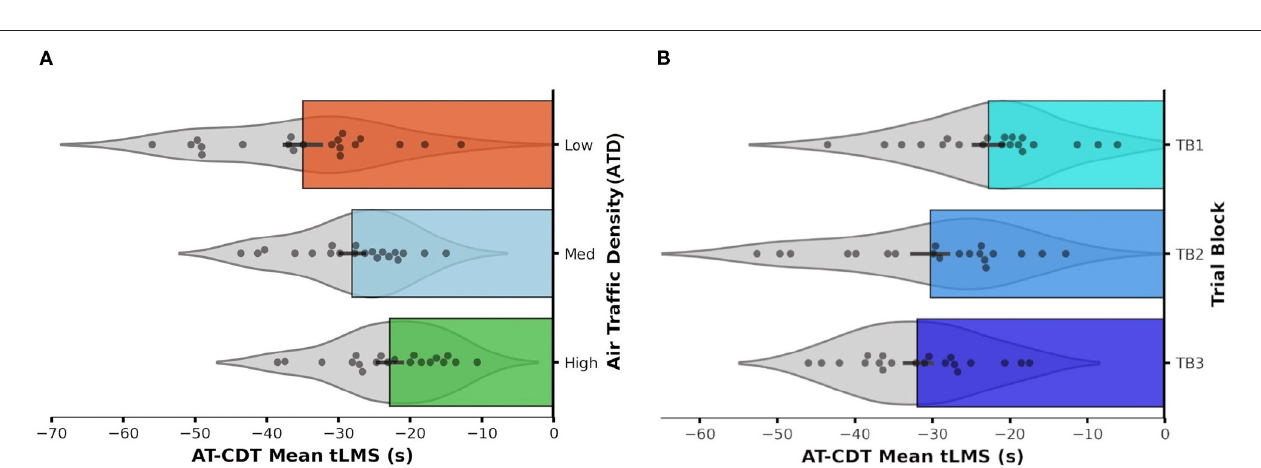
FIGURE 10 | Horizontal bar graph with violin plots showing the distribution of mean Air Traffic Conflict Detection Task (AT-CDT) time to loss of minimum separation (tLMS) values obtained from each participant under (A) each air traffic density (ATD) condition and within (B) each trial block (TB). Longer bars represent faster responses associated with quicker detections of conflicts. Each error bar represents ± 1 SE . Zero on the x-axis marks the time-point at which a conflict event occurs. The violin plot overlaid on each bar represents the probability density function (PDF) of the data distribution falling within (A) each ATD condition and (B) TB. Each PDF was mirrored along the central horizontal axis of each bar. There was no prominent skewness in data distribution in any ATD condition or TB. also significantly faster than those from the first, third,